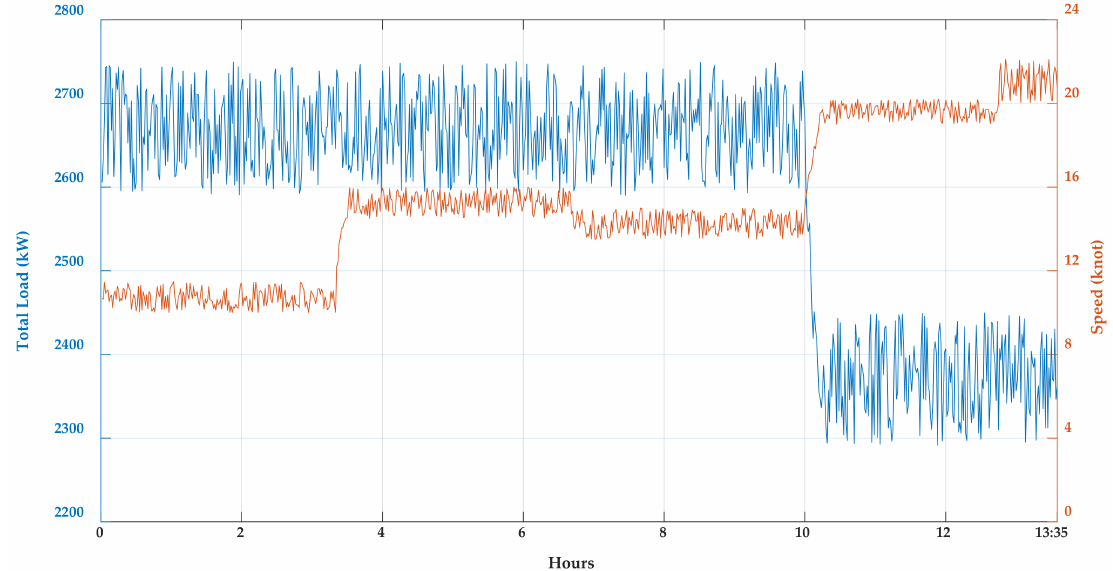
Figure 3. Example of the test sailing data with the total load and